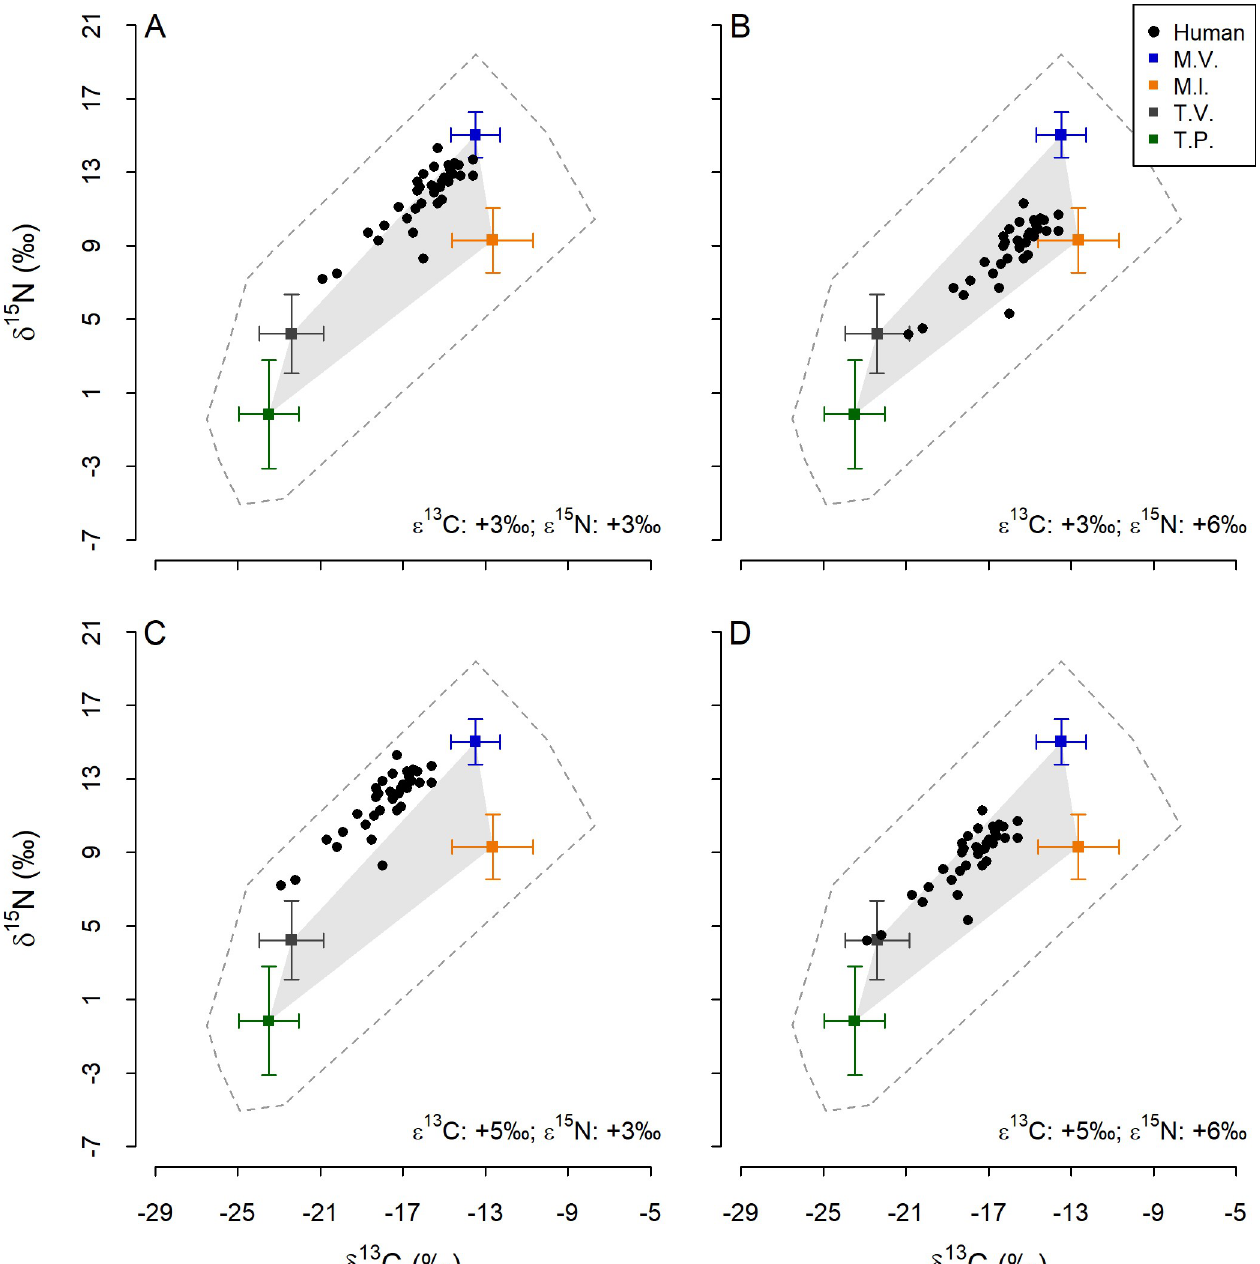
Fig 4. Isotope ratios of Later Stone Age humans and food groups from the Cape Peninsula. Symbols denote humans and food groups as indicated in the legend. The dashed grey outline indicates the minimum convex polygon around all raw values and the solid grey polygon the minimum convex polygon around mean values for food groups. Squares and error bars show mean values and standard deviations for each group. T.P. = terrestrial plant, T.V. = terrestrial vertebrate, M.I. = marine invertebrate and M.V. = marine